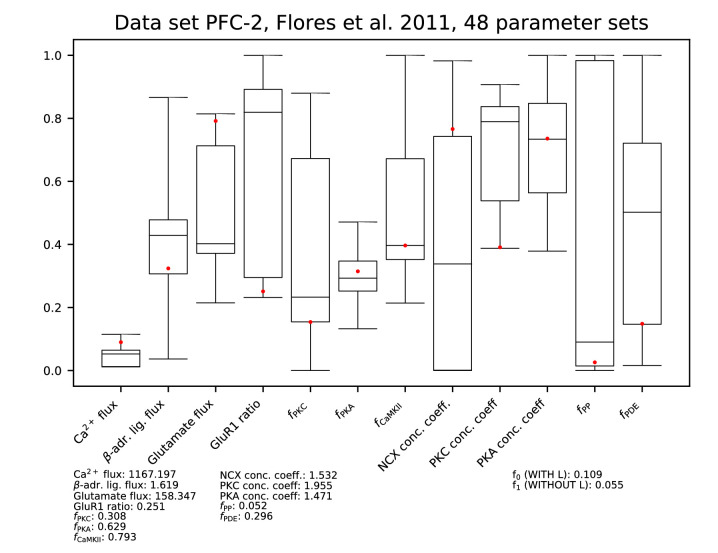
Parameters for data set PFC-2.See Figure 9—figure supplement 1 for details.